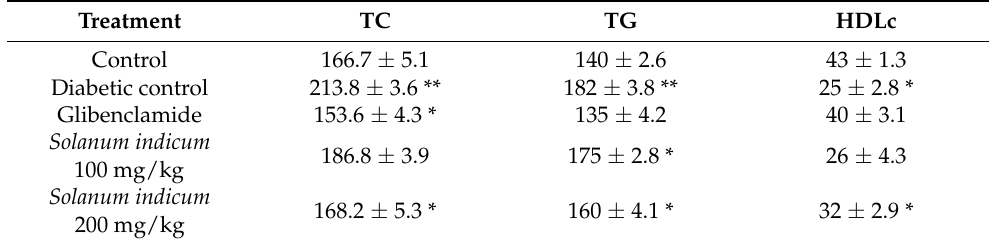
Table 7. Effect of the extract of Solanum indicum fruits on lipid profile in STZ-induced diabetic rats.